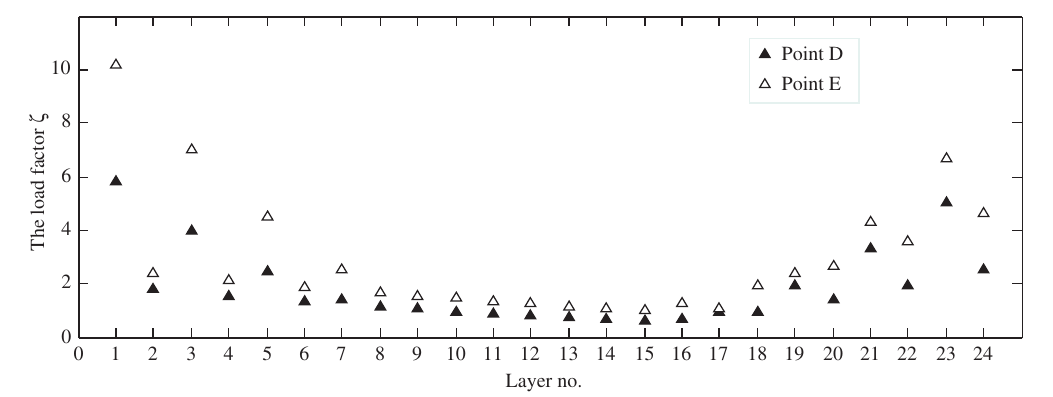
Figure 11: The load factor ζ of each layer at point C.